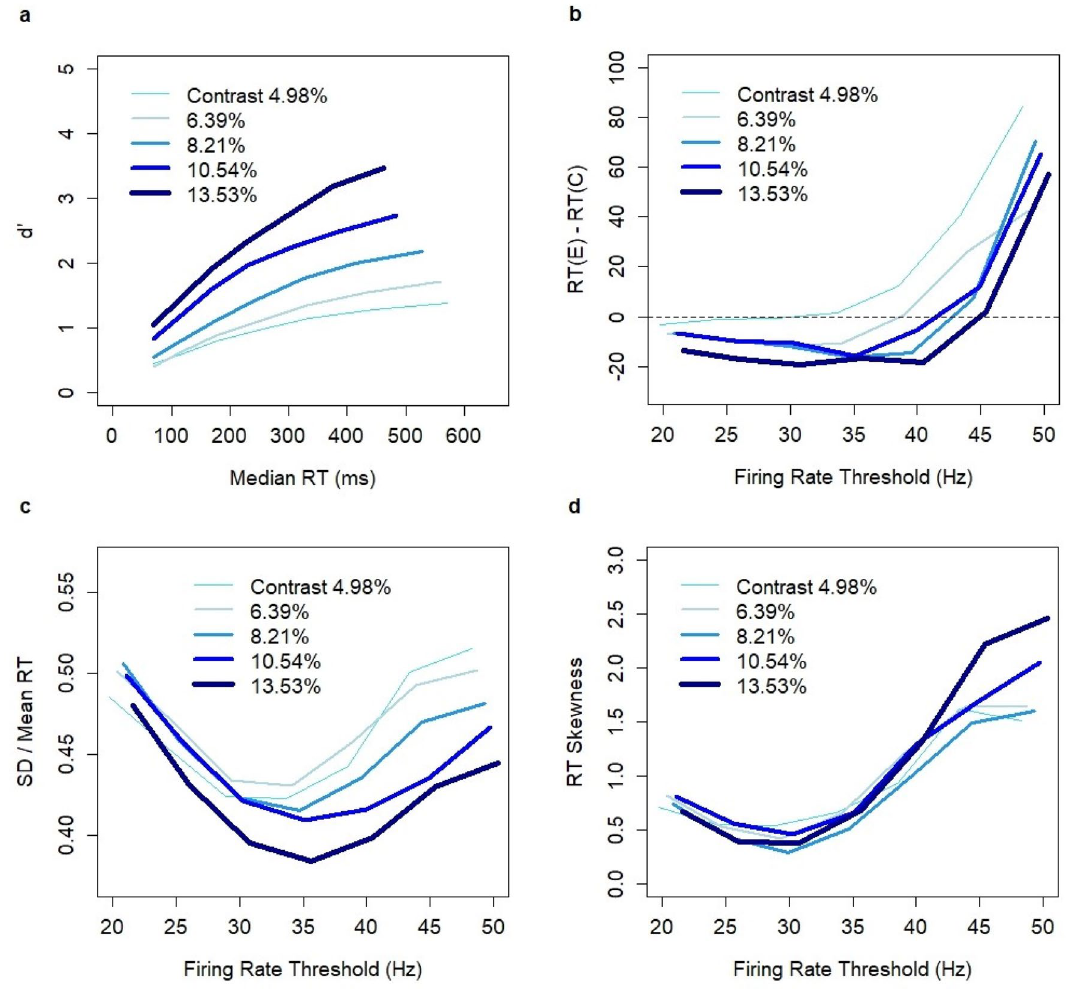
Figure 4. Model predictions based on N = 15,000 simulations (3000 per contrast level) with SAT effects implemented through a population-average firing rate threshold. Each data point reflects a different threshold level: 20, 25, 30, 35, 40, 45, or 50 Hz. ( a ) Speed-accuracy tradeoff for five contrast levels (4.98–13.53%). ( b ) Difference between RT (ms) on erroneous and correct decisions as a function of firing rate threshold (range: 20–50 Hz) in the winning pool. ( c ) Ratio between standard deviation and mean RT. ( d ) Skewness of the RT distribution. No non-decision constant was